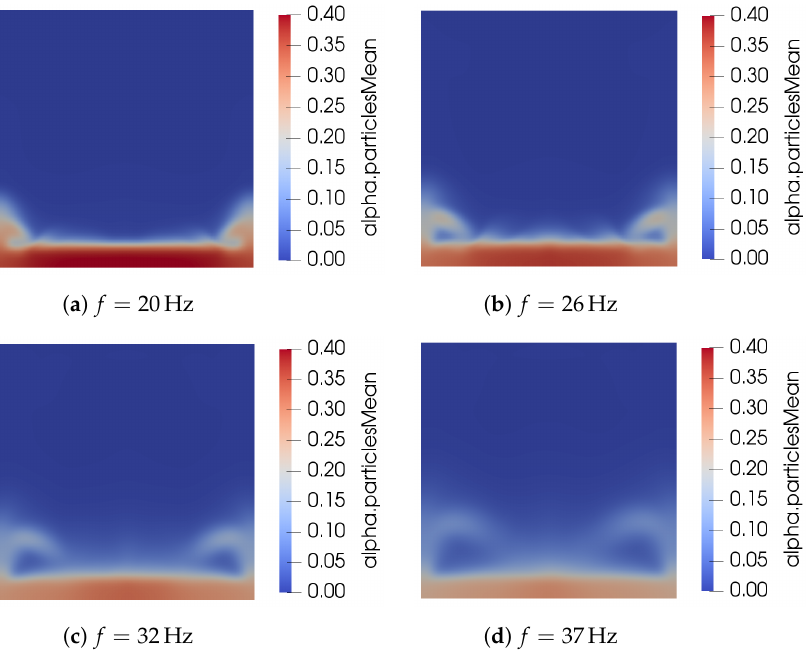
Figure 4. Effect of frequency on solid volume fraction